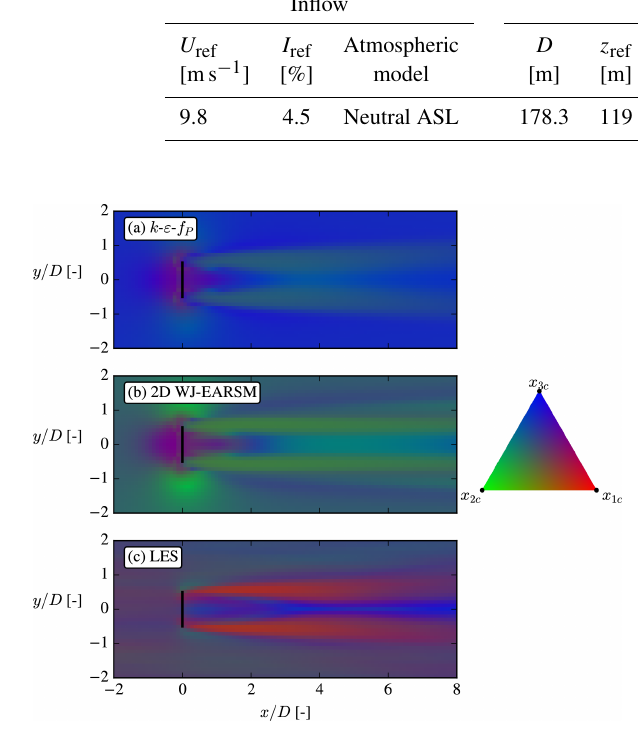
Figure 19. RGB-colored turbulence componentiality at hub height for the single-wake V80